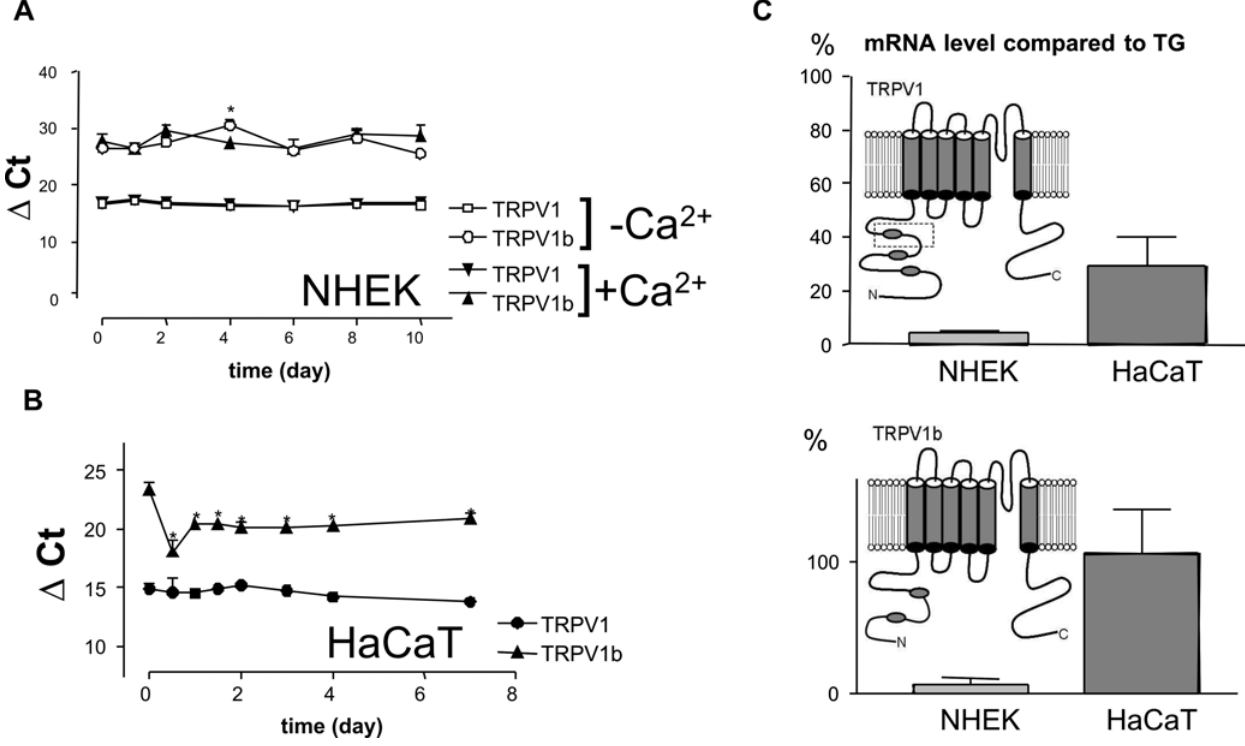
Figure 3. Keratinocytes express low levels of the full length TRPV1 transcript together with transcript of the TRPV1b dominant negative splice form. Detection of TRPV1 transcript in differentiating human cultured keratinocytes (NHEK) (A) and HaCaT cells (B) by real-time RT- PCR. TRPV1 threshold cycle numbers normalized to the internal control 18S rRNA (delta CT) are plotted. The amount of mRNAs is inversely proportional to the plotted threshold cycle numbers. Data are presented as means of three independent experiments. (*: p , 0.05, Dunnet test). The amount of mRNA was also compared in samples from cultured keratinocytes, human HaCaT cells and human trigeminal ganglion (C). The schematic model of TRPV1 and TRPV1b is shown in the corresponing graphs.